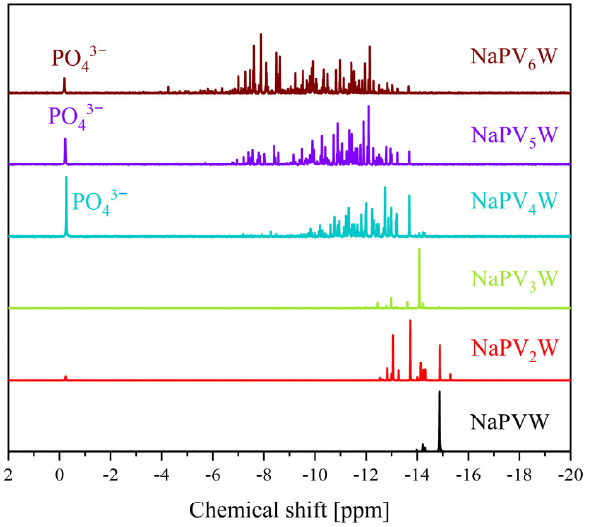
Figure 6. 31 P-NMR spectra of the POMs NaPV x W, with x = 1 to 6. All spectra were measured in a mixture of 70% water (pH 1) and 30% D 2 O. Measurement frequency: 242.9 MHz; 85% H 3 PO 4 was used as an external standard.